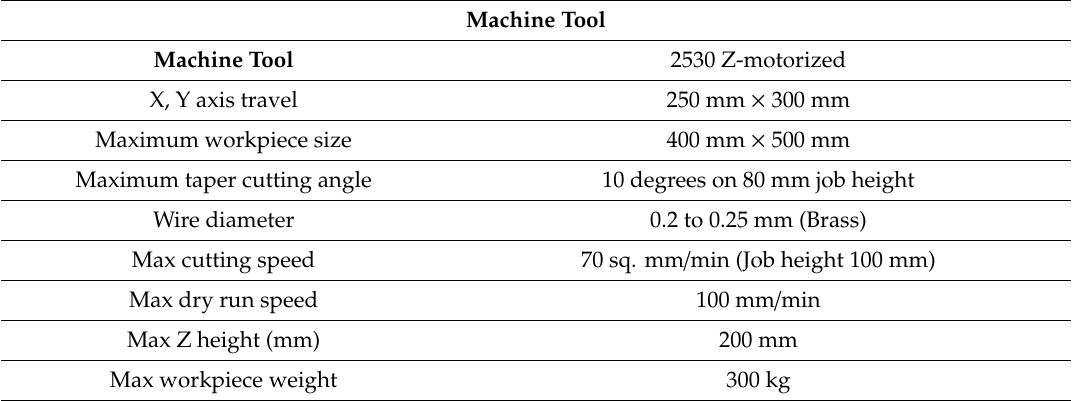
Table 1. Wire electrical discharge machine specifications-RP Smartcut